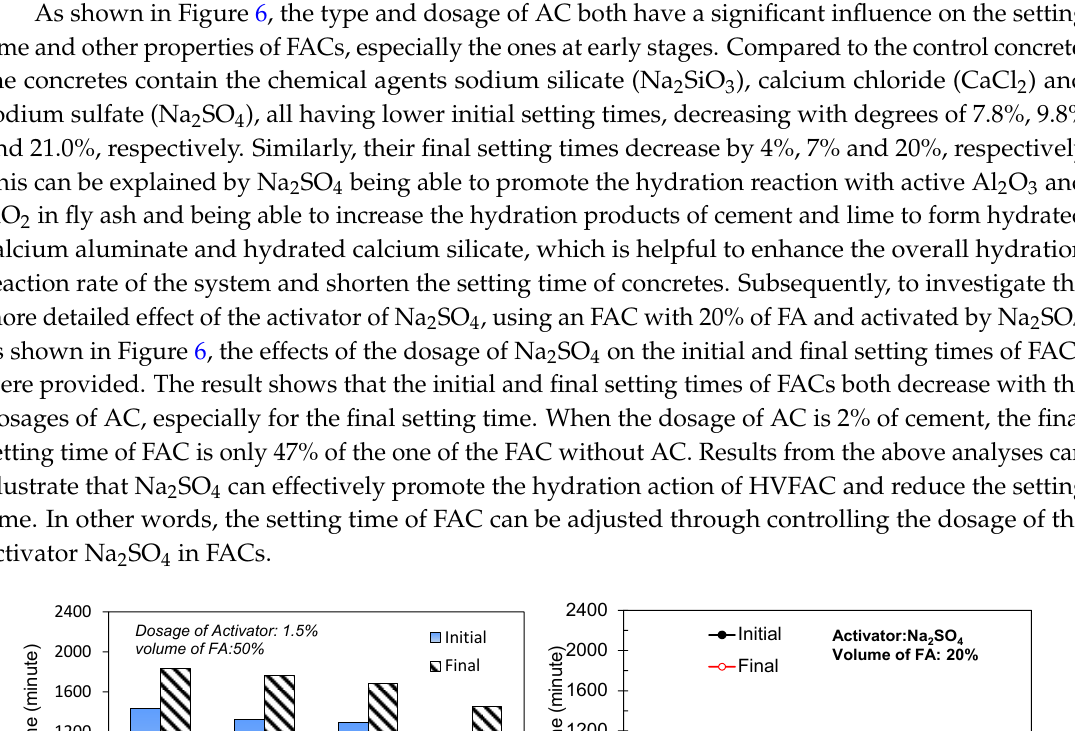
Figure 5. Effect of the mass of FA on setting time.